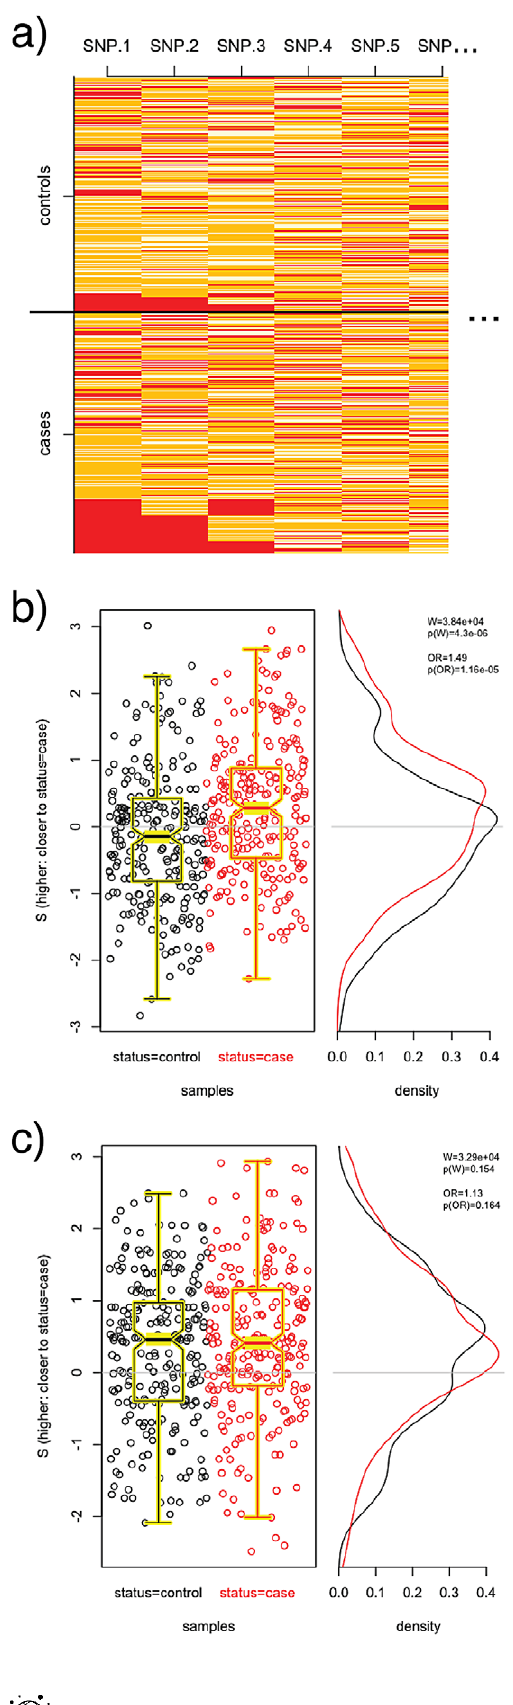
Figure 1. PoDA applied to simulated data. Alleles at 50 loci for 250 cases and 250 controls were simulated such that each SNP was in HWE and not associated with case status, but homozygous minor (red) at both loci 1 and 2 or 1 and 3 yielded a three-fold relative risk (a). A 12- SNP pathway comprising SNPs 1–12 shows differential S distributions (b); a random 12-SNP pathway does not (c). Boxplots are overlayed on the scatterplots of S for